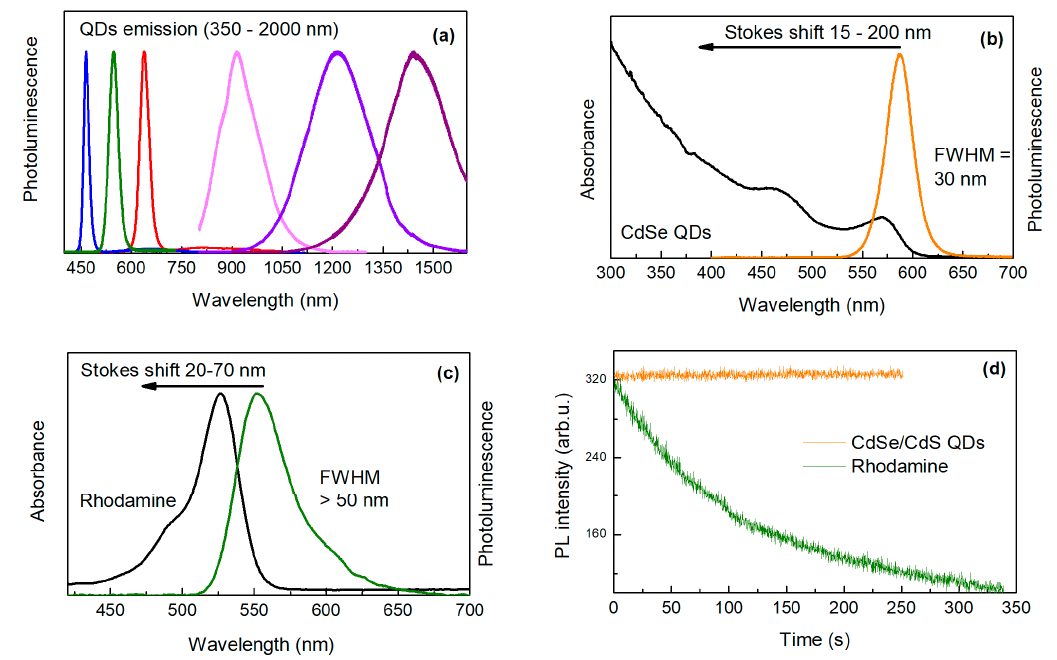
Figure 2. ( a ) Emission spectra from CdS QDs (left side) and PbS QDs (right side) with different size and chemical composition; ( b ) absorbance and emission spectra of CdSe/CdS quantum dots; ( c ) emission and absorption spectra of Rhodamine; ( d ) emission intensity vs illumination time for CdSe/CdS QDs and Rhodamine.